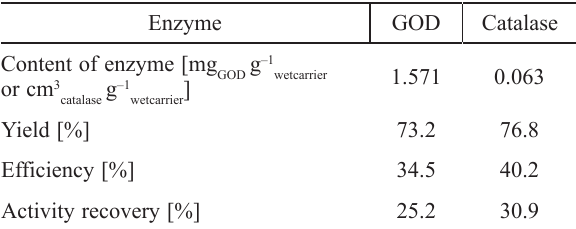
Table 1 – Success of immobilization of GOD and catalase on Eupergit C Enzyme